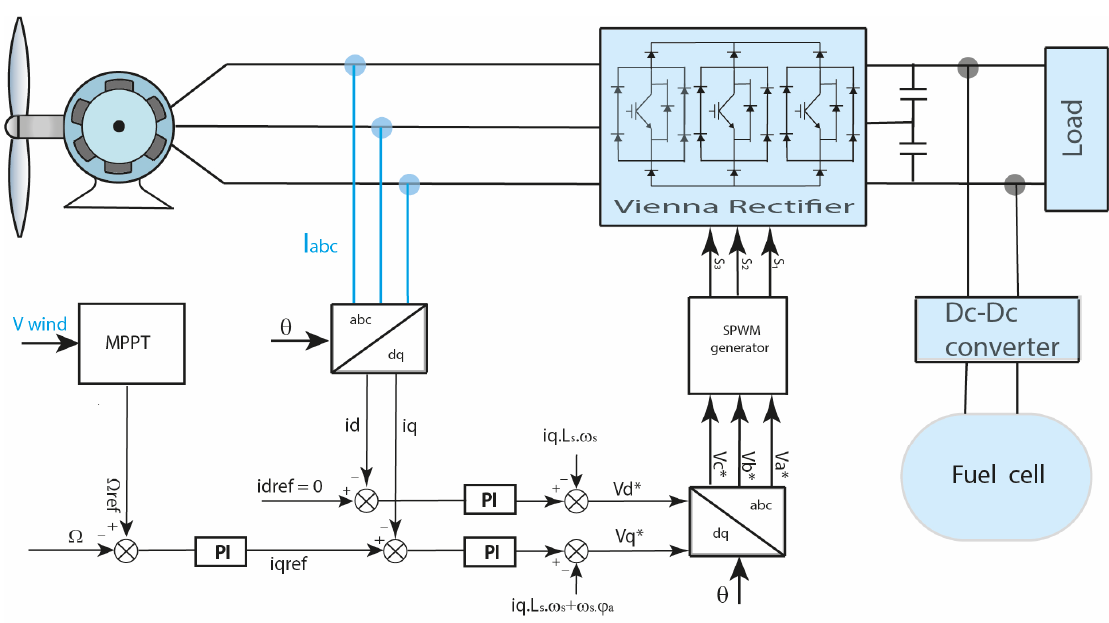
Figure 5. Vienna rectifier control strategy-based MPPT technique for wind turbine applications.